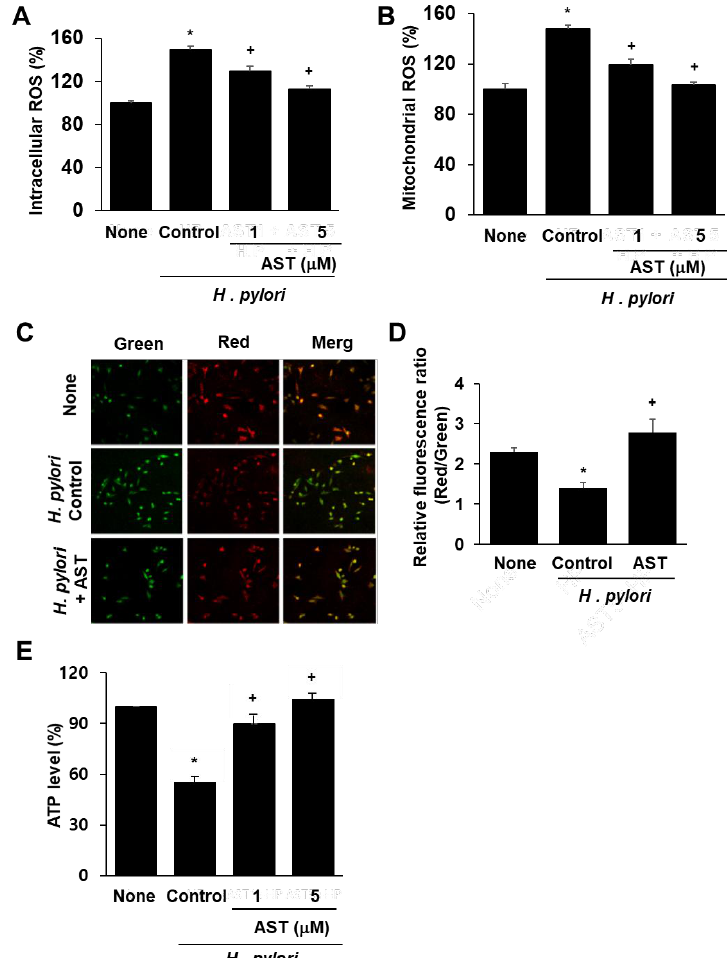
Figure 1. Effect of astaxanthin on ROS levels and mitochondrial dysfunction in H. pylori -infected AGS cells. The cells were pre-treated with the indicated concentrations of astaxanthin for 3 h and then stimulated with H. pylori for 1 h. ( A ) Intracellular ROS levels measured by DCF-DA fluorescence for uninfected AGS cells (None), AGS cells infected with H. pylori (Control; * p < 0.05 vs. None), AGS cells infected with H. pylori and treated with 1 or 5 μ M astaxanthin (AST; + p < 0.05 vs. Control). ( B ) Mitochondrial ROS levels were measured by MitoSOX fluorescence and reported the same as in ( A ). ( C ) MMP of AGS cells without infection (None), infected with H. pylori alone (Control) or with H. pylori infection plus treatment of 5 μ M astaxanthin (+AST) and stained with JC-1 dye and visualized with a confocal laser scanning microscope. ( D ) Relative ratios of red and green fluorescence densities of uninfected AGS cells (None), H. pylori -infected AGS cells (Control; * p < 0.05 vs. None) and H. pylori infection plus treatment of 5 µ M astaxanthin (+AST; + p < 0.05 vs. Control). ( E ) Relative intracellular ATP levels measured for uninfected and infected AGS cells. See ( A ) for key to figure